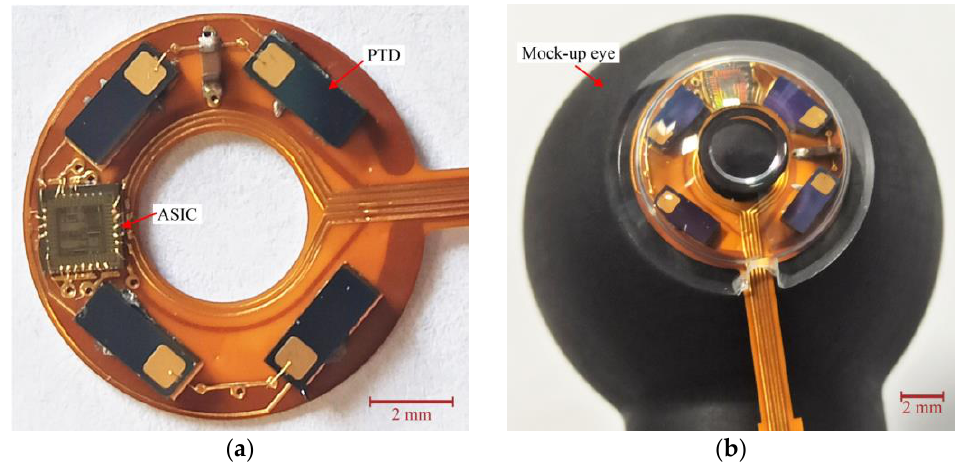
Figure 4. Prototype of the SCL electronics: ( a ) before encapsulation, ( b ) encapsulated.